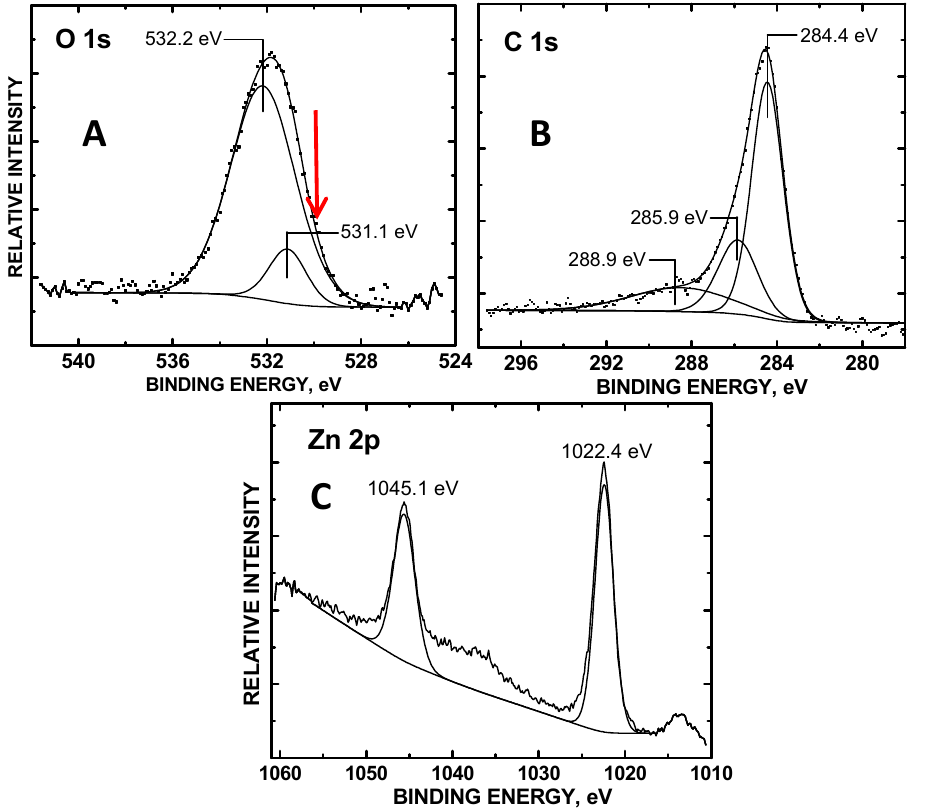
Figure 1. XPS narrow scans of the ( A ) O 1s, ( B ) C 1s, and ( C ) Zn 2p orbitals of the 150 sonicated refluxed ZnO/carboxylic acid functionalized multi-walled carbon nanotube (COOH-MWNT) composite. The red arrow in ( A ) denotes the BE position of ZnO oxidation state.